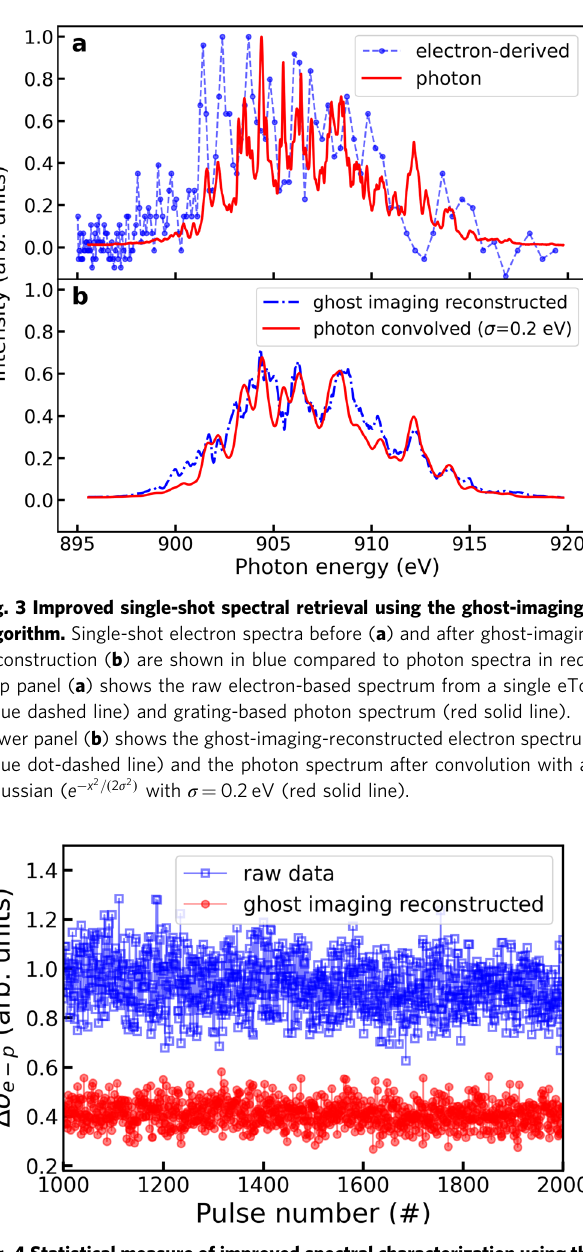
Fig. 4 Statistical measure of improved spectral characterization using the ghost-imaging algorithm. Δ σ e-p (Eqn. (3)), the standard deviation of the difference between electron-based and direct photon measurements, is plotted against pulse number. The Δ σ e-p are shown before (blue, open square) and after (red, solid dot) the ghost-imaging reconstruction. The response matrix R used here was determined using data from six electron time-of- fl ight spectrometers (eToFs) and all N = 15,337 shots. The results for 1000 shots are shown here.